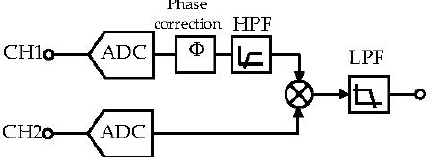
Figure 9. Block diagram of the system for determining the power from the u ( t ) and i ( t ) waveforms.